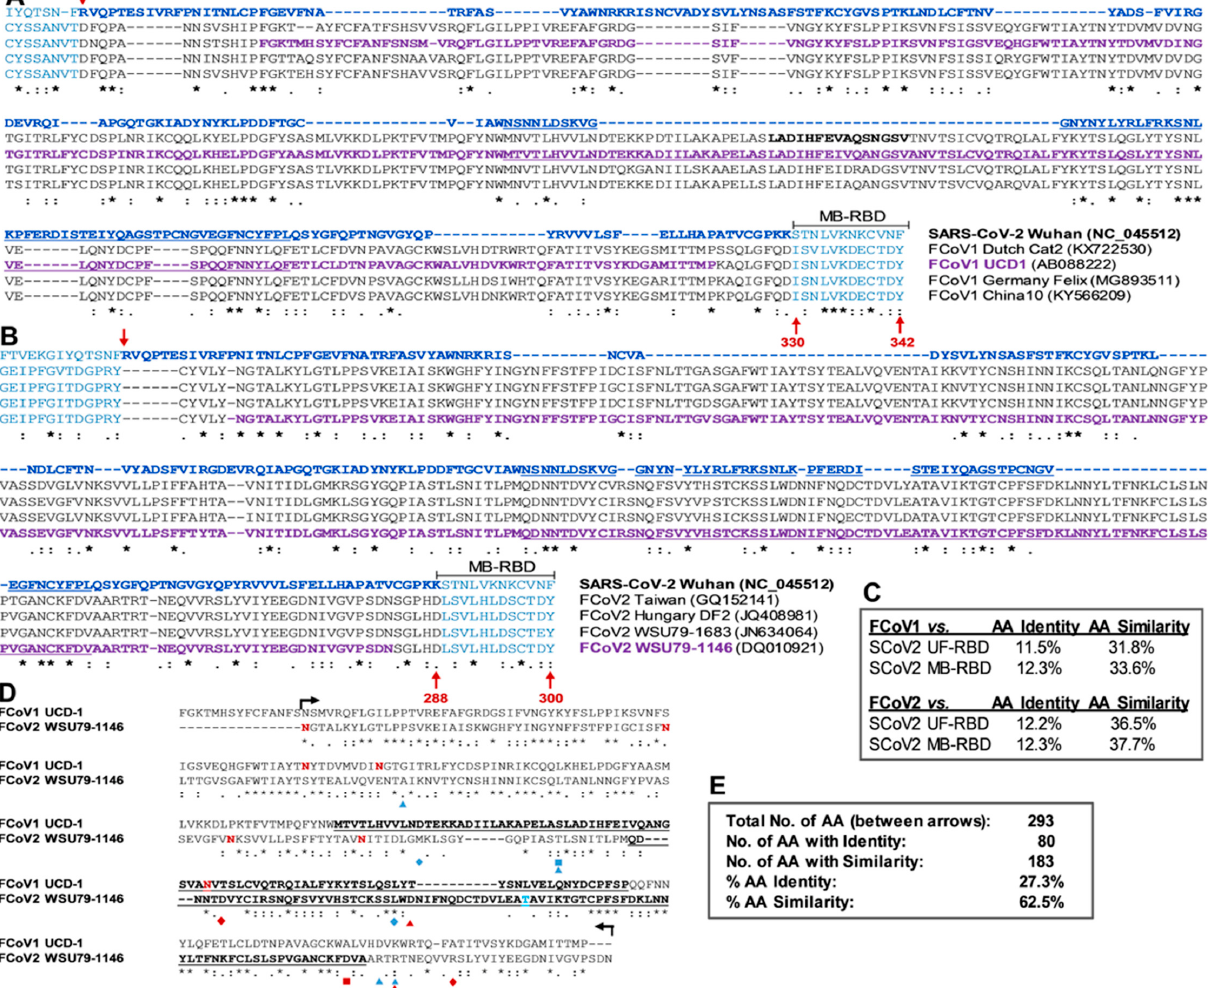
Figure 2. Amino acid (aa) sequence alignment of SCoV2 Wuhan RBD along with proposed FCoV1 RBD ( A ) and with proposed FCoV2 RBD ( B ) using multi-alignment analysis with four FCoV strains. In order to prevent one strain anomaly, four strains of FCoV1 ( A ) were aligned with SCoV2 Wuhan RBD by Clustal Omega 1.2.1 of JustBio Server (https://justbio.com/). The SCoV2 Wuhan RBD sequence is shown at the top in blue, and the SCoV2 receptor binding motif (RBM) is underlined. Magenta-colored RBD sequence belongs to the proposed FCoV1 UCD-1 RBD sequence ( A , second FCoV1 sequence) and the proposed FCoV2 79-1146 RBD sequence ( B , fourth FCoV2 sequence). The blue-labeled residues below the MB-RBD bracket represent MassBiologic’s SCoV2 RBD with the extra 12 residues. The identical and similar aa residues are shown with an asterisk (*) for complete identity, strong similarity with a colon (:), and modest similarity with a single dot (.). The gaps are shown with a dash (-). The aa sequence identity and similarity for UF-RBD (without carboxyl-end 12 aa residues) and MB-RBD sequences are summarized ( C ), starting with arginine (R) on the amino end of SCoV2, pointed downward with a red arrow, and ending with an upward red arrow, with the number of aa for UF-RBD or MB-RBD with gaps. Next, the proposed FCoV1 UCD-1 RBD sequence (aa residues 406–684) and the proposed FCoV2 79-1146 RBD sequence (aa residues 408–675) were aligned similarly using JustBio Server ( D ). The bolded, underlined sections represent potential RBM regions based on counterpart SCoV2 RBM regions in Figure S2 for FCoV2 79-1146 and Figure S3 for FCoV1 UCD-1. The FCoV1 UCD-1 RBD has three N-glycosylation sites with a high prediction, as shown with a bolded red N and no O-glycosylation, based on the NetNGlyc 1.0 Server and